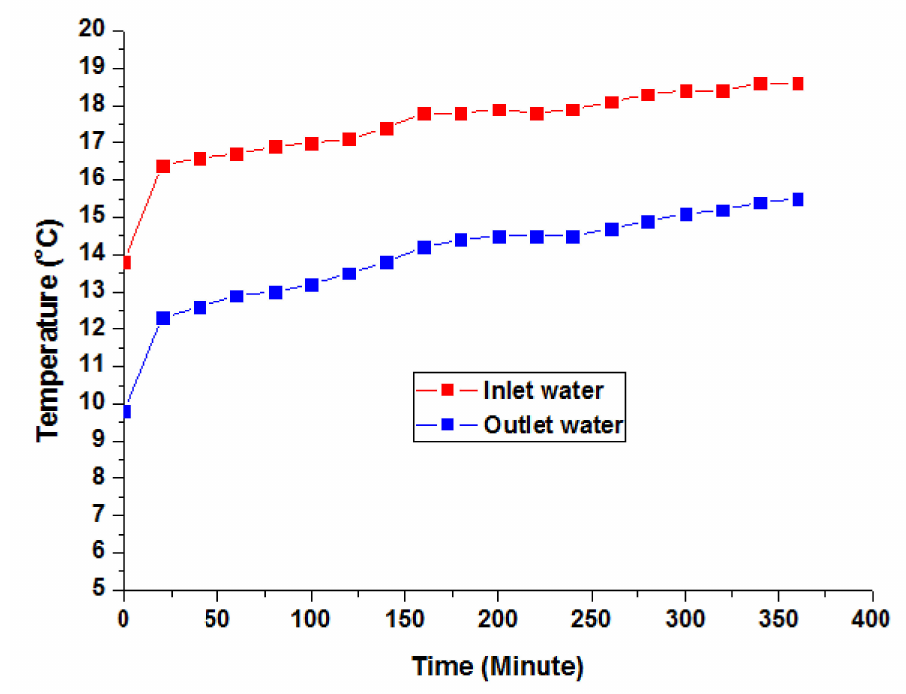
Figure 11. Changes in heat transfer fluid temperature during discharging process.